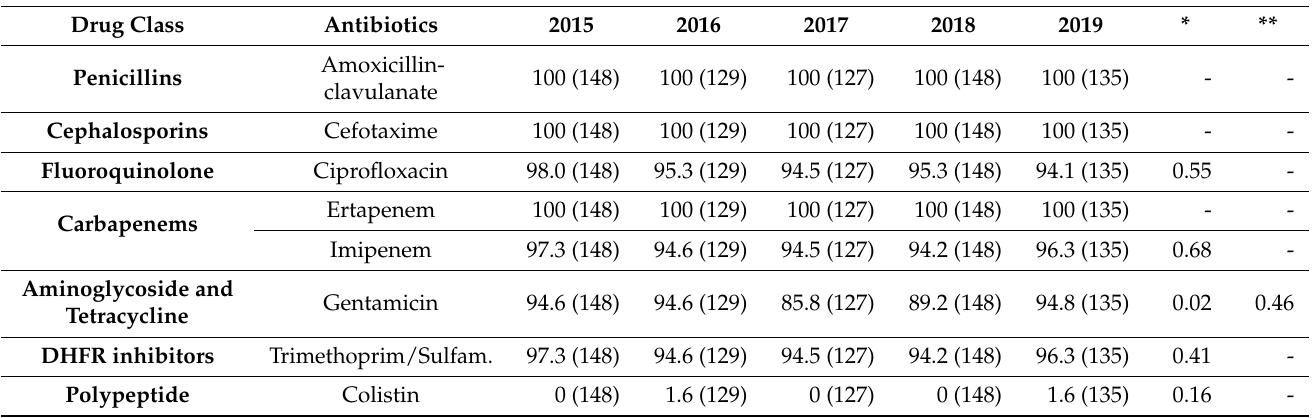
Table 5. Antimicrobial resistance profile of Acinetobacter baumannii to antibiotics used in